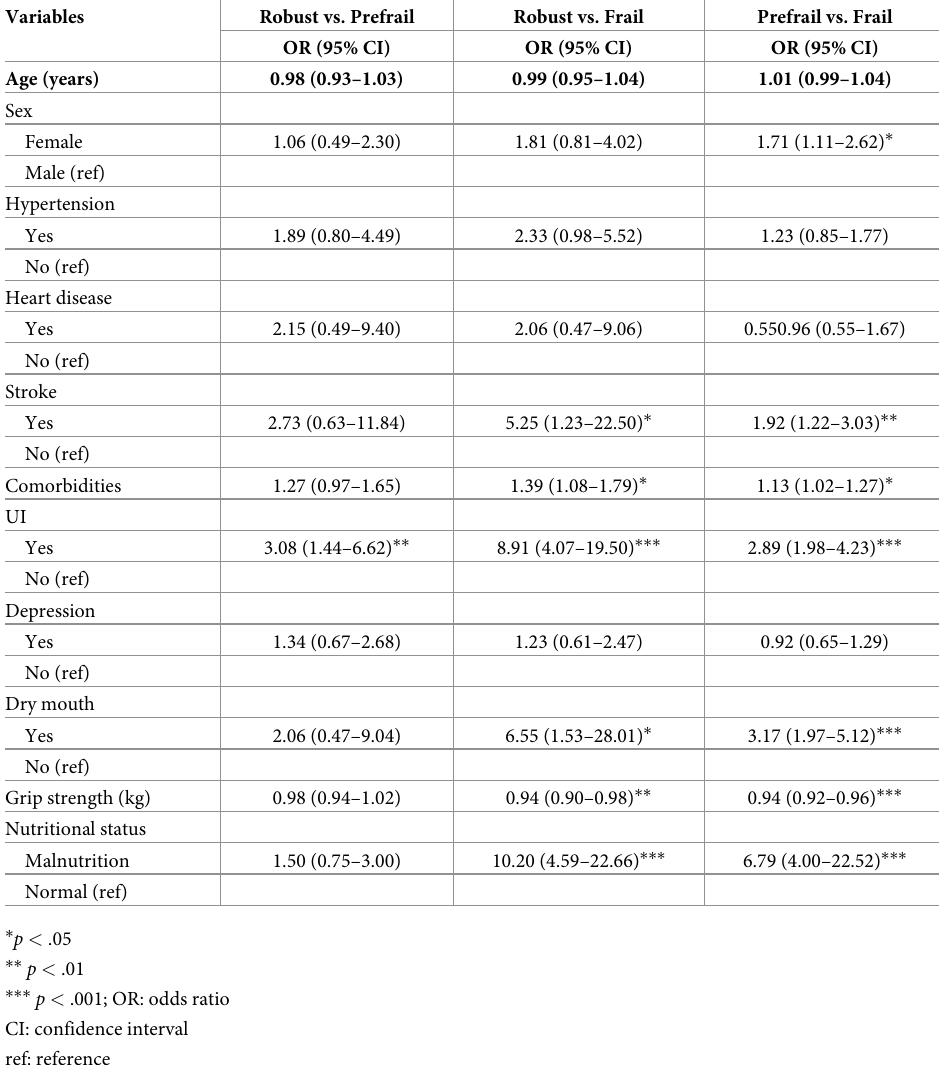
Table 2. Univariate logistic regression models for frailty (N =